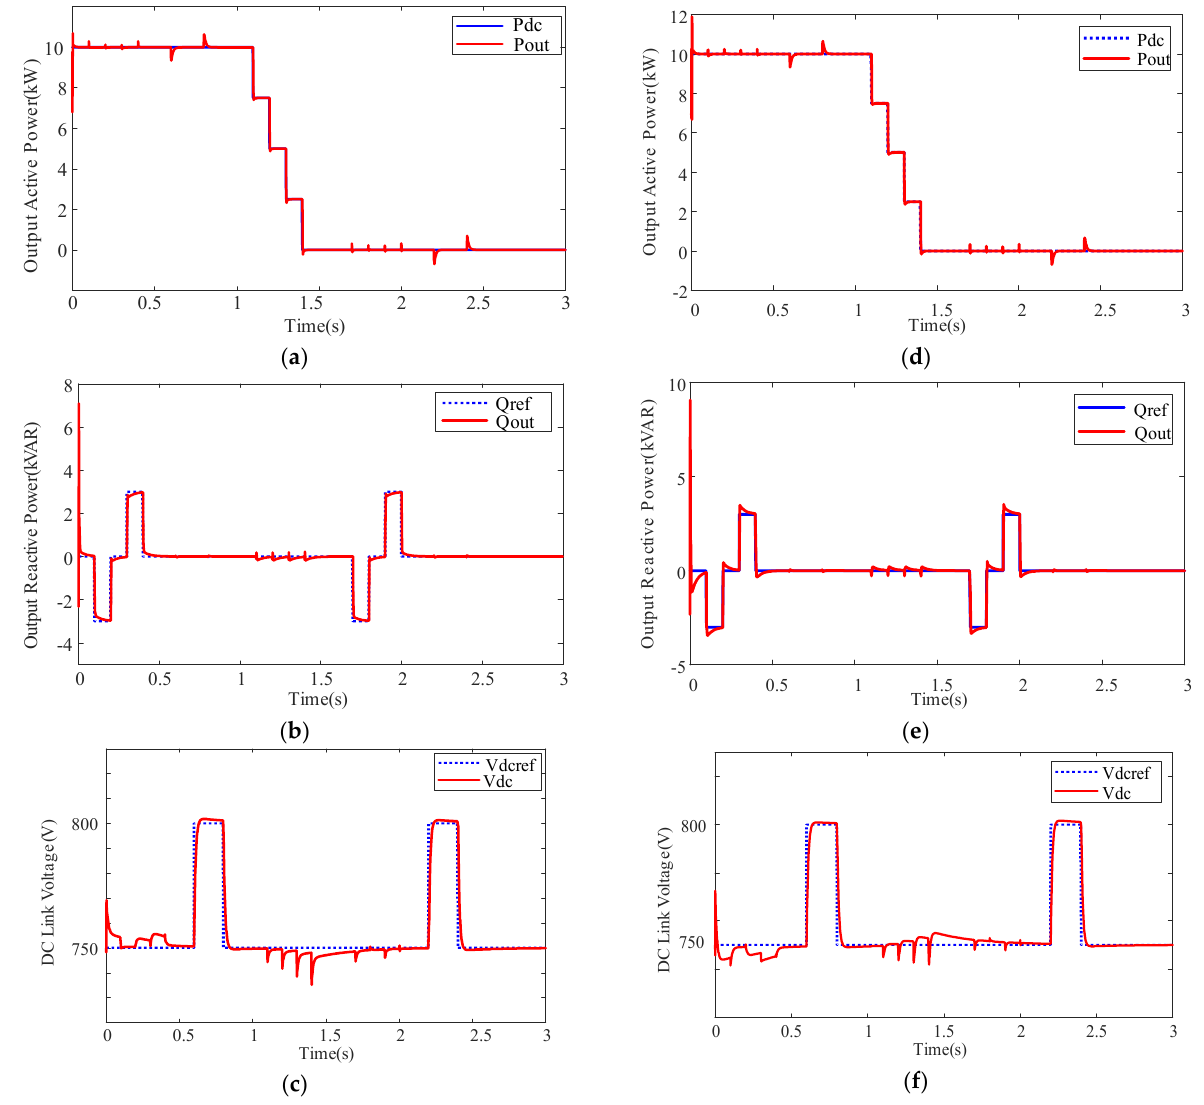
Figure 8. Dynamic response of the system in the presence of uncertainty in output filter inductance, ( a – c ) output active and reactive power and DC-link voltage of the GFL inverter in presence of +20% uncertainty in L f , and ( d – f ) output active and reactive power and DC-link voltage of the GFL inverter in presence of − 20% change in L f